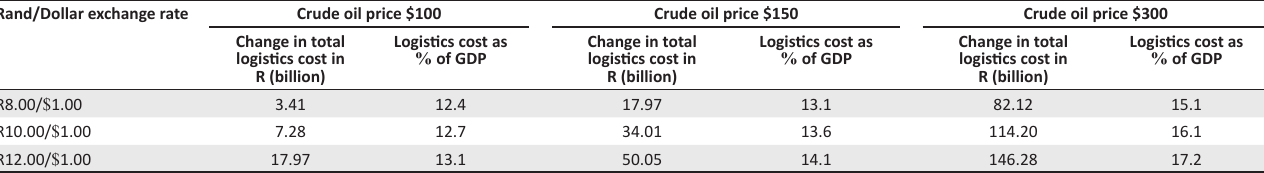
TABLE 1: The potential impact of the crude oil price and the exchange rate on national logistics costs in 2012. Rand/Dollar exchange rate